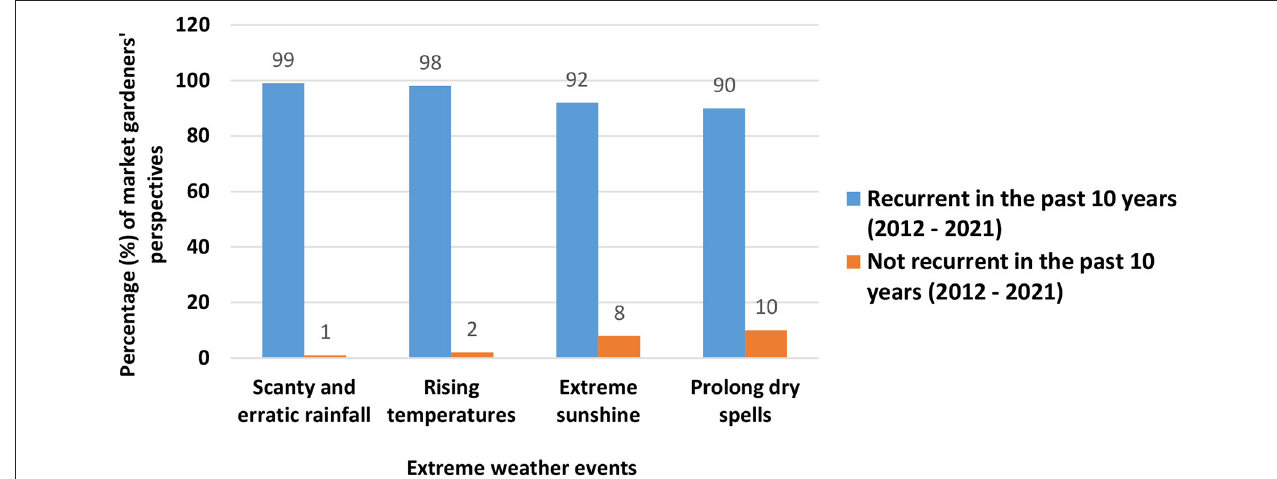
FIGURE 1 | Farmers’ perspectives on recurrence of extreme weather events.